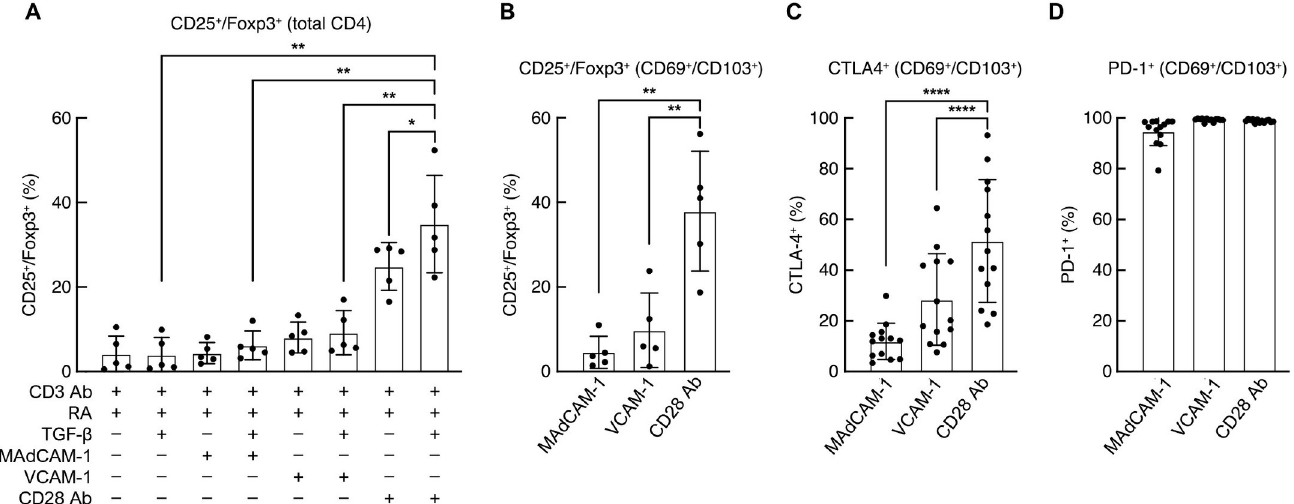
Fig 3. CD25/FoxP3, PD-1 and CTLA-4 expression following costimulation. Flow cytometric analysis of ( A ) CD25/FoxP3 co-expression on total CD4 + T cells following costimulation with MAdCAM-1, VCAM-1 and CD28 Ab in the presence of RA and TGF- β as indicated (n = 5). Expression of ( B ) CD25/FoxP3 (n = 5), ( C ) CTLA-4 (n = 13), and ( D ) PD-1 (n = 13) within the CD69 + /CD103 + population following costimulation with MAdCAM-1, VCAM-1 and CD28 Ab, in the presence of RA and TGF- β ( � : P < 0.05, �� : P < 0.01, ���� : P < 0.0001, two-tailed t test).